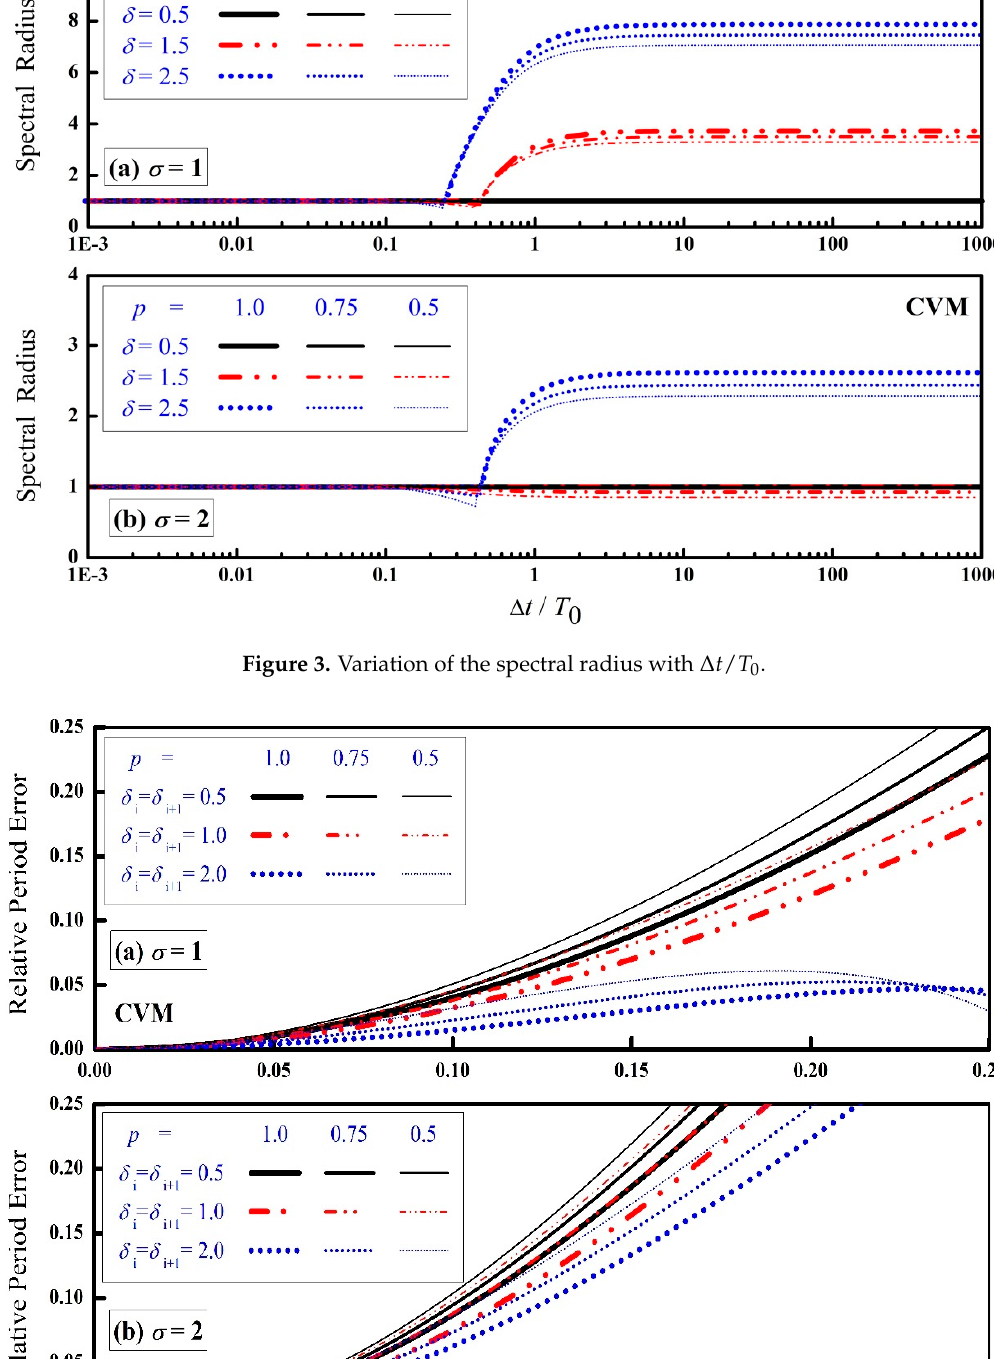
Figure 4. Variation of the relative period error with